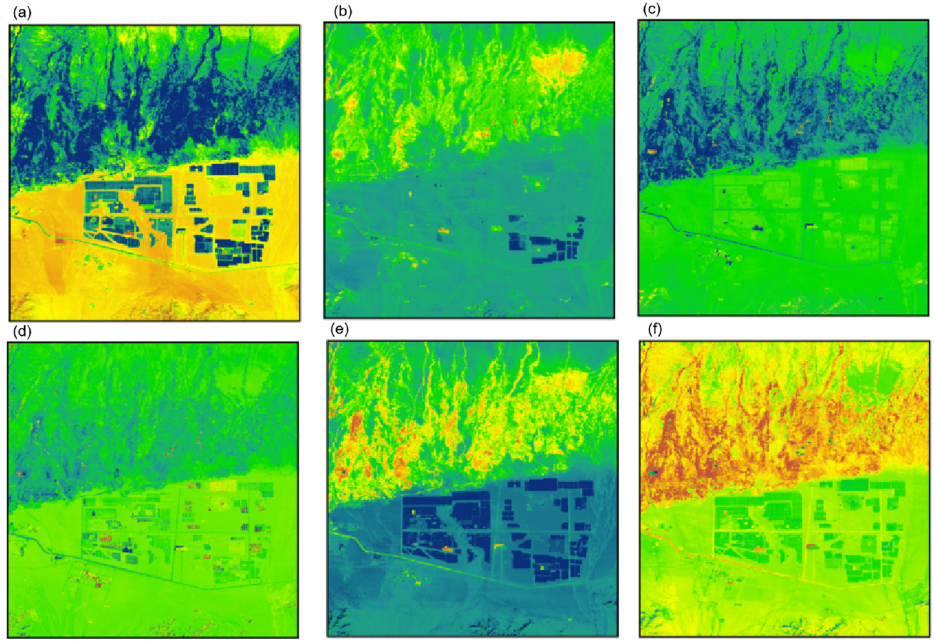
Figure 4. Images associated with different indices for areas hosting PV plants in Golmud